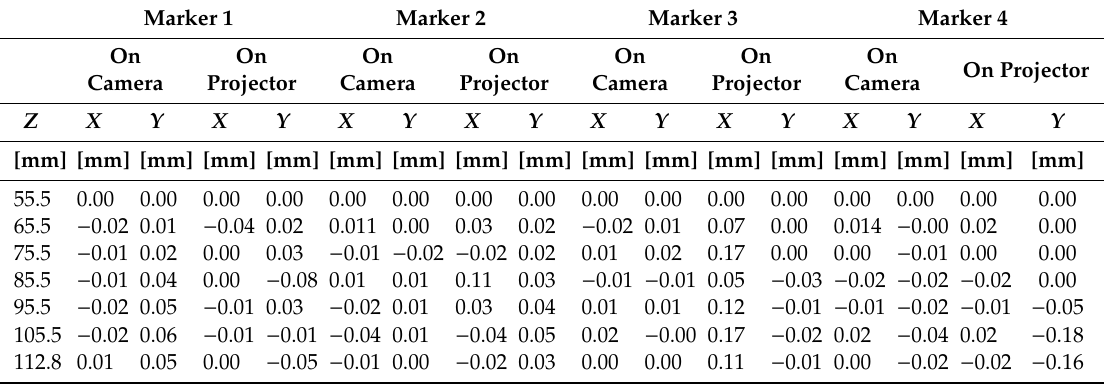
Figure 14. Object tracking accuracy calculated for four calibration markers (1–4) at heights above the working table in the range of 55–112.5 mm imposed by mechanical limits of the lift table. Table 2. Object-tracking reprojection error at specific height (along Z -axis) above the table. Marker 1